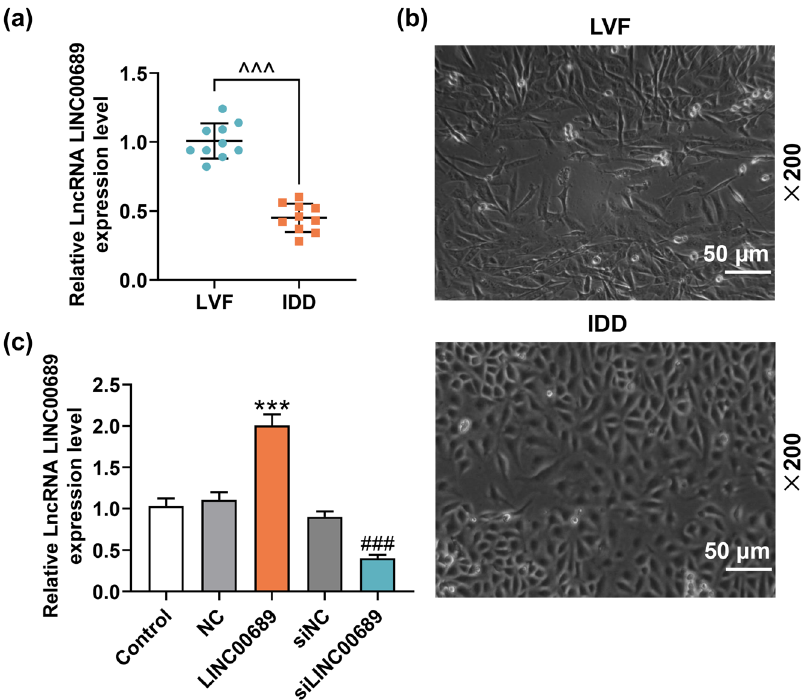
Figure 1: The level of LINC00689 was down - regulated in IDD tissue. ( a ) The level of LINC00689 in NP tissue samples was measured by qRT - PCR, and the expression of LINC00689 was lower in IDD group than that in LVF group. ( b ) The NPCs were extracted from collected NP tissues, and then the cell morphology of NPCs was observed under an inverted microscope ( under 200 × magni fi cation, scale bar = 50 μ m ) . ( c ) The expression of LINC00689 in transfected NPCs was measured by qRT - PCR. ^^^ P < 0.001 vs LVF; *** P < 0.001 vs NC; ### P < 0.001 vs siNC ( LINC00689: long non - coding RNA LINC00689, IDD: intervertebral disc degeneration, LVF: lumbar vertebrae fractures, NPCs: human nucleus pulposus cells, NP: nucleus pulposus, siLINC00689: small interfering RNA speci fi cally targeting LINC00689, NC: negative control, qRT - PCR: quantitative RT - PCR )